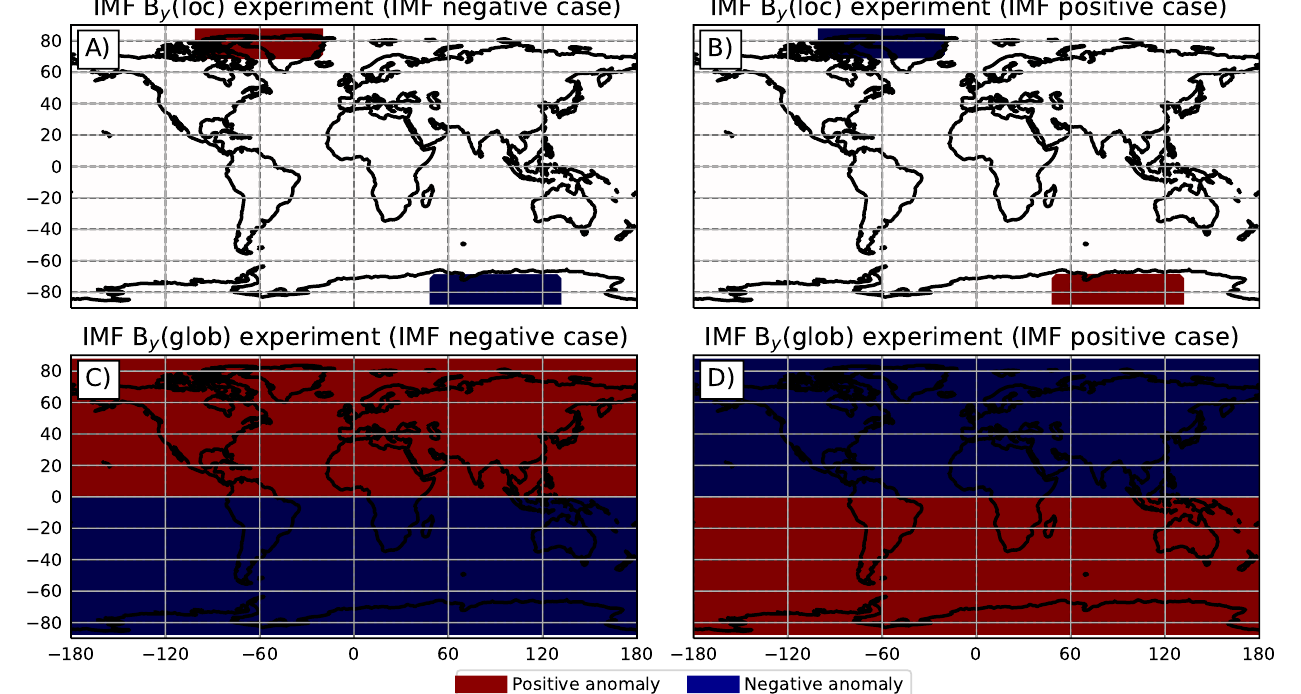
Figure 3. The geography of IMF B y -associated anomalies applied in IP, J z , and cloud droplet coales- cence rate. Panels A and B: anomalies used in IMF B y (loc) experiment for negative ( A ) and positive ( B ) IMF B y state; panels C and D: anomalies used in IMF B y (glob) experiment for negative ( C ) and positive ( D ) IMF B y state. Red region: positive anomaly; blue region: negative anomaly. After, the data residuals were sorted by five daily-mean IMF B y intervals: strongly positive (IMF B y ≥ 3 nT), moderately positive (3 nT > IMF B y ≥ 1 nT),